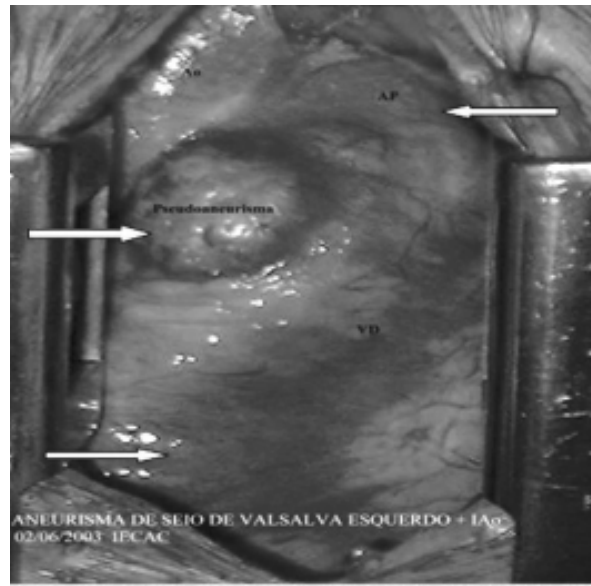
Fig. 1 - Aneurisma distendendo a parede anterior do ventrículo direito, bloqueado apenas pelo epicárdio. A seta superior direita mostra o tronco da artéria pulmonar e a inferior aponta a parede anterior do ventrículo direito